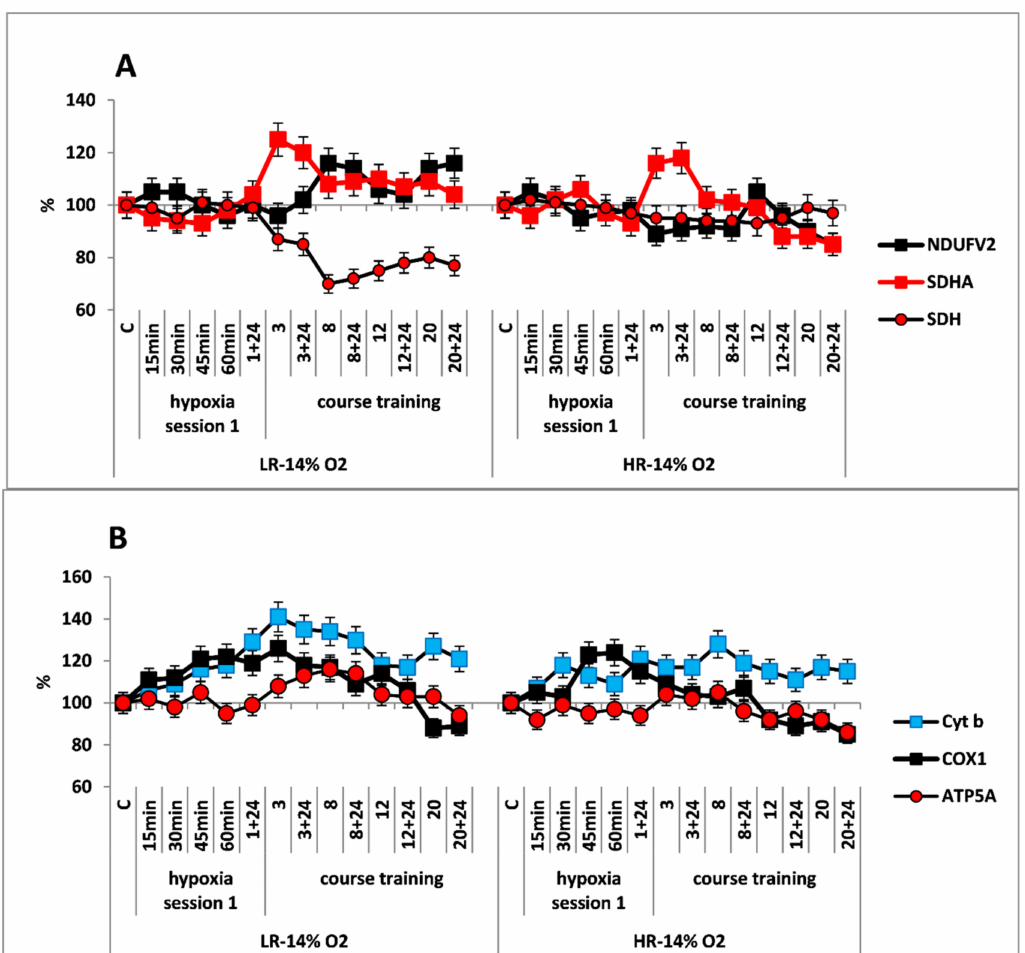
Figure 2. Effect of long-term hypobaric hypoxia (HBH, 14% O 2 ; 20 daily one-hour sessions) on the dynamics of the CC content of mitochondrial enzymes in low-resistance (LR) and high-resistance (HR) rats. Abscissa: time points of the long-term hypoxic training, at which study parameters were measured: 15, 30, 45, 60 min: first hypoxic exposure; 3, 8, 12, and 20: number of conducted sessions; 3 + 24, 8 + 24, 12 + 24, 20 + 24: at 24 h after the latest hypoxic exposure. ( A ) NDUFV2 (MC I), SDHA (MC II) catalytic subunits (% of control) and SDH activity. ( B ) Cyt b (MC III), COX1 (MC IV) and ATP5A (MC V) catalytic subunits (% of